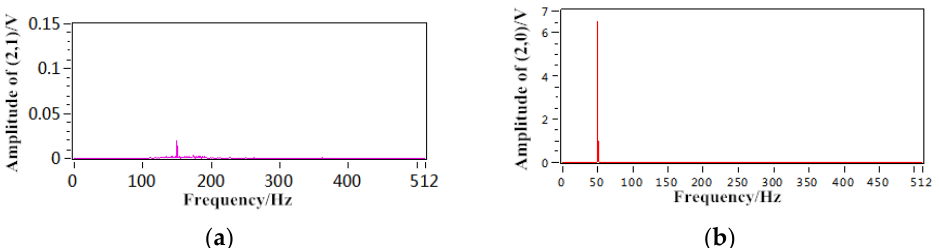
Figure 9. Spectrum diagrams of the current signal: ( a ) spectrum diagram of the normal motor; and ( b ) spectrum diagram of the fault motor.